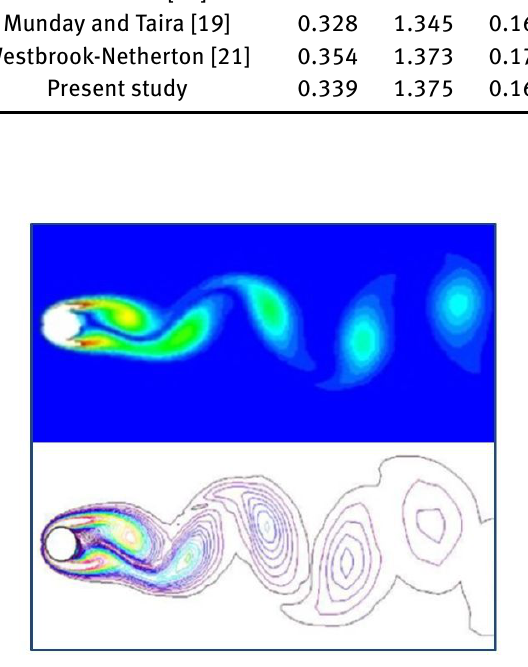
Figure 6: Comparison of instantaneous vorticity field at Re = 100 between the present work (top) and the work presented by Placzek et al. [16]